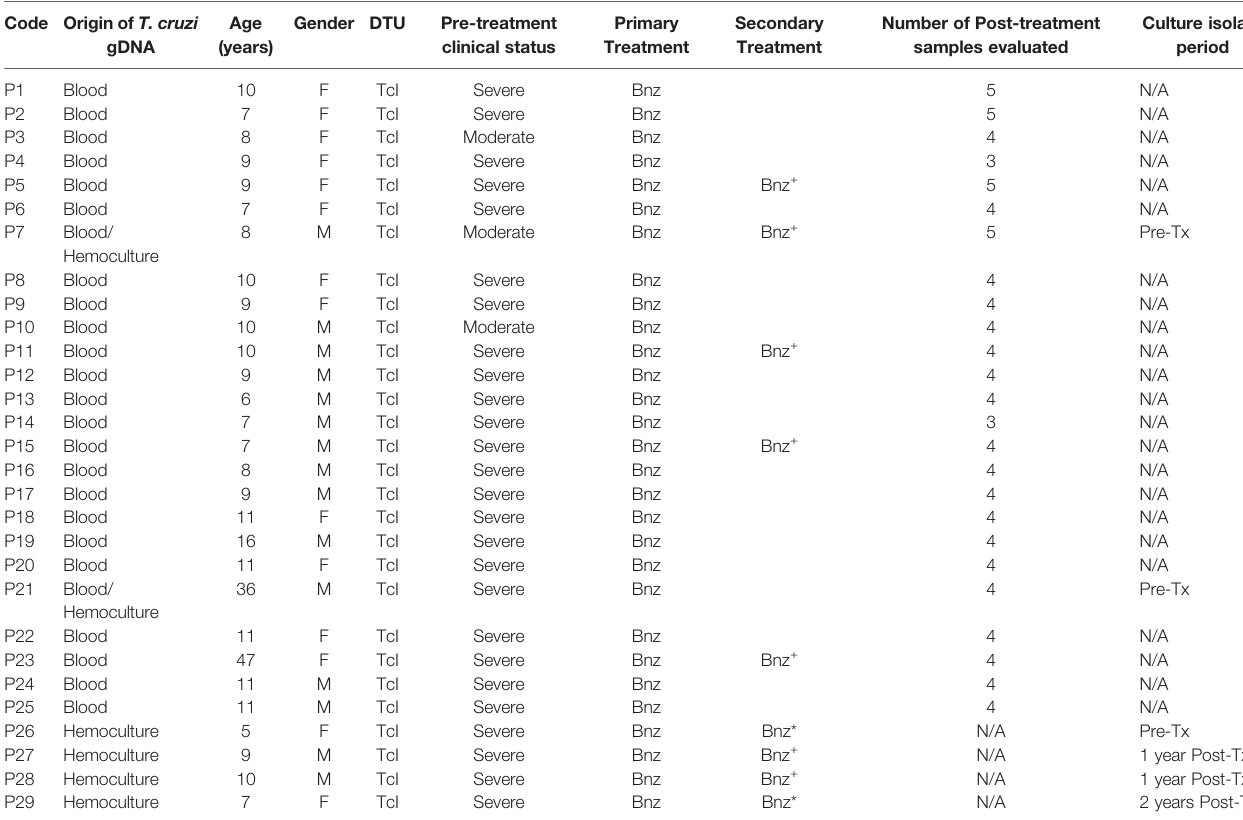
TABLE 1 | Description of the Oral Chagas Disease patients´ cohort with Pre and Post treatment follow-up samples for 9 years. Code Origin of T. cruzi